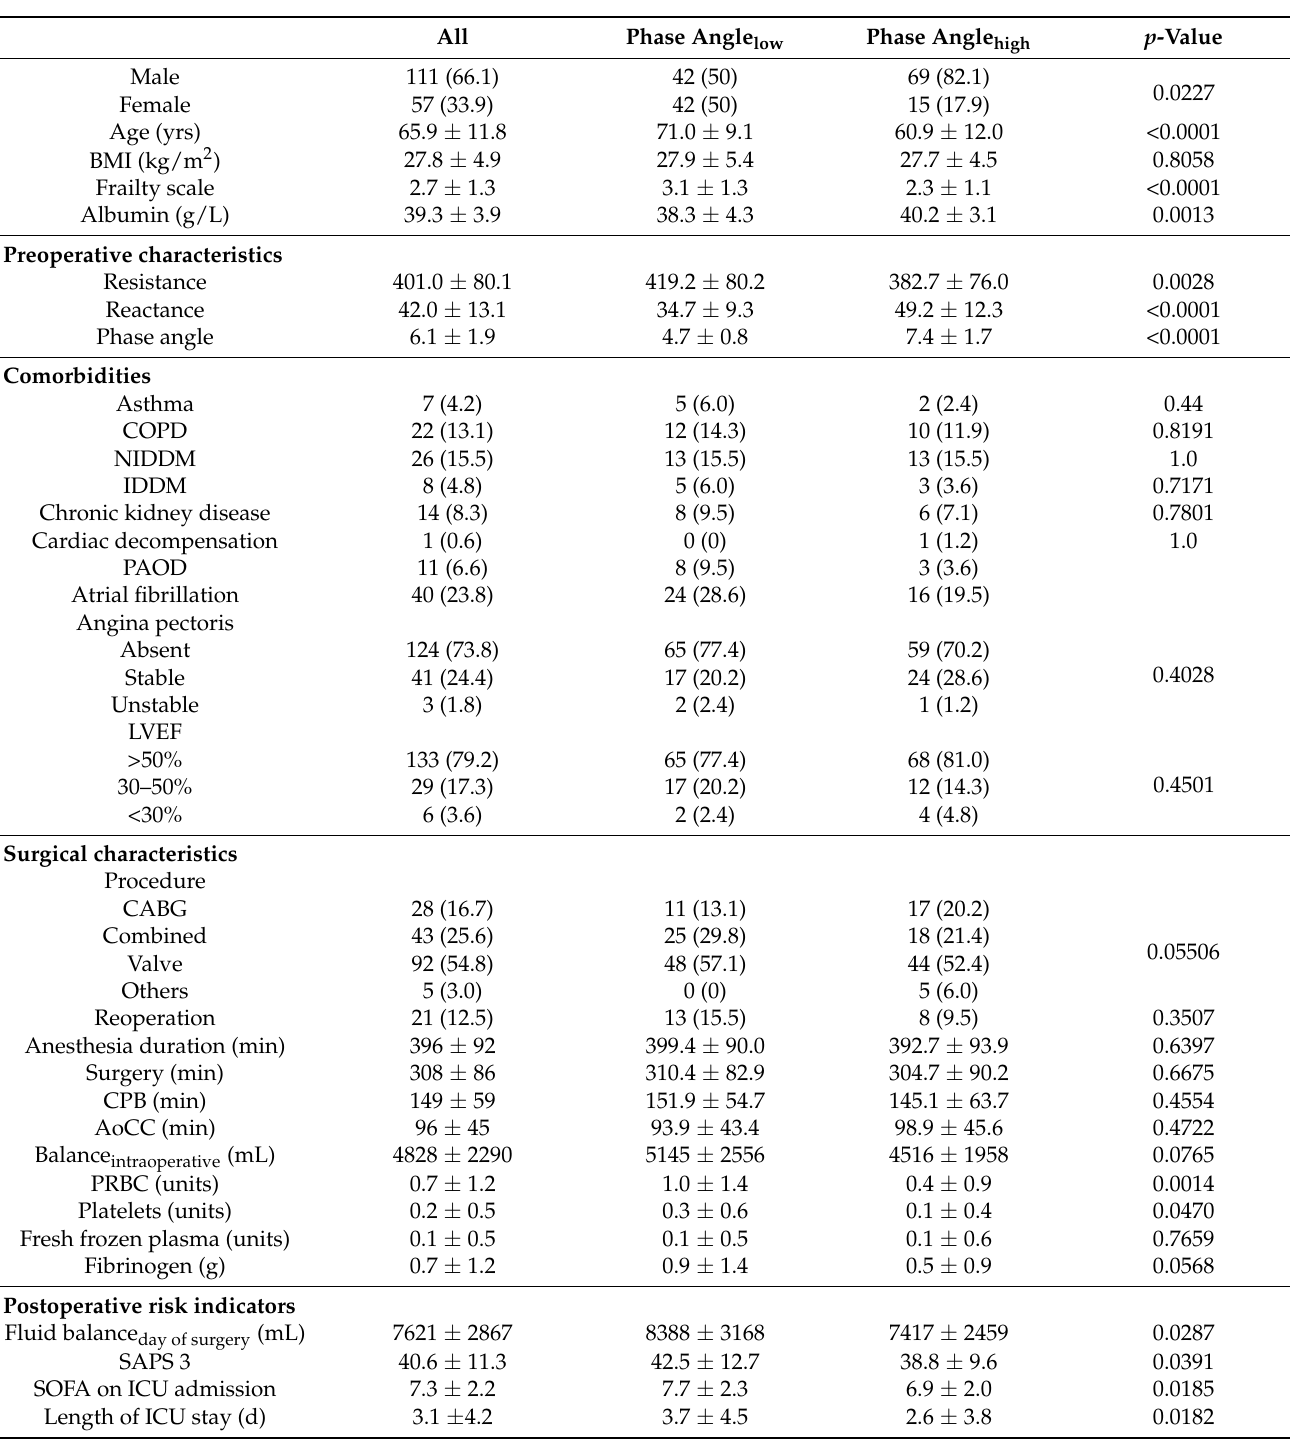
Table 1. Demographic and surgical